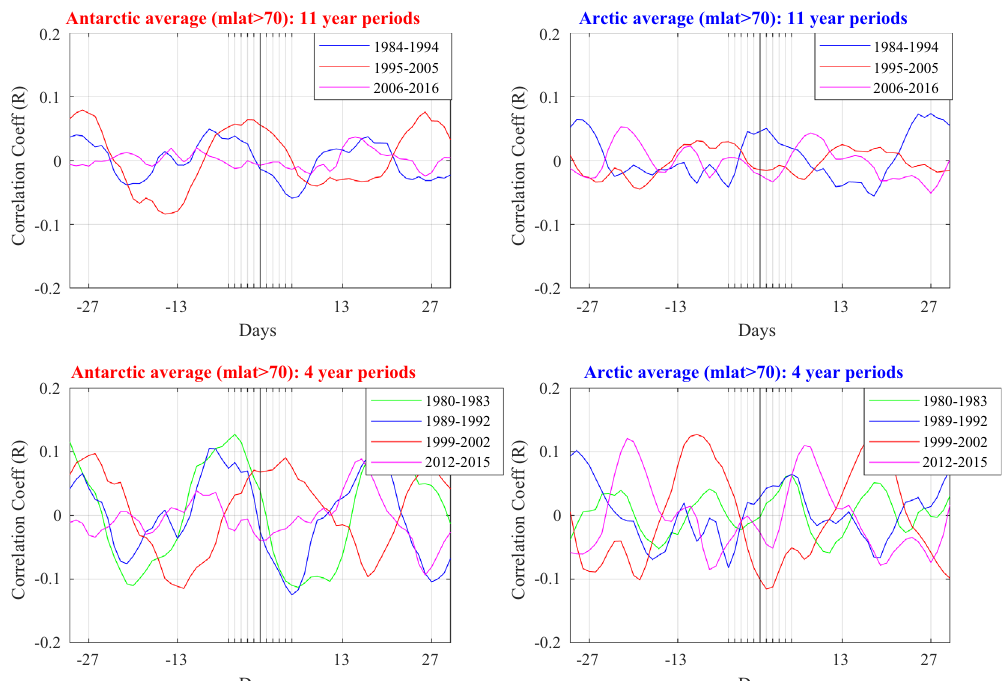
Fig. 7. Lead – lag correlation coef fi cients between D Z g and B y in both hemispheres for three 11-year periods spanning 1984 – 2016 ( top panels ) and four 4-year periods centered around solar maximum ( bottom panels ).